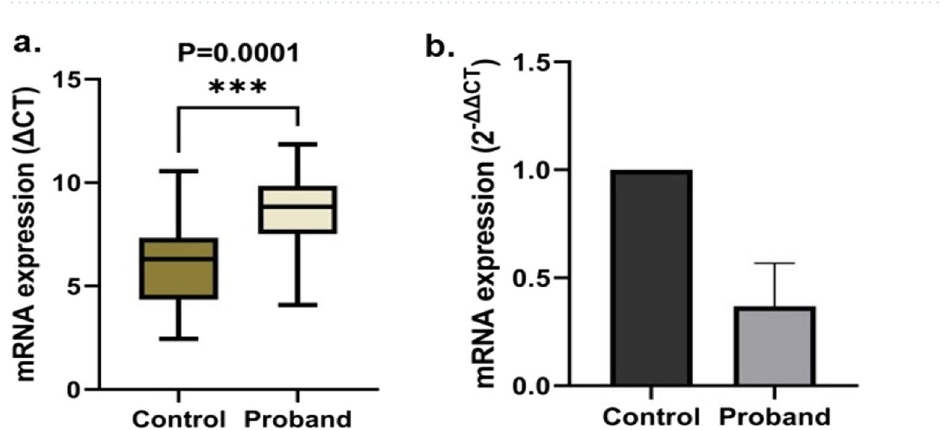
Figure 2. Relative GRIK1 mRNA expression in the peripheral blood of controls and ADHD probands were analyzed by the Unpaired t-test using the Prism 9.0 software; a. box plot shows ΔCT values, b. bar diagram shows the fold change in